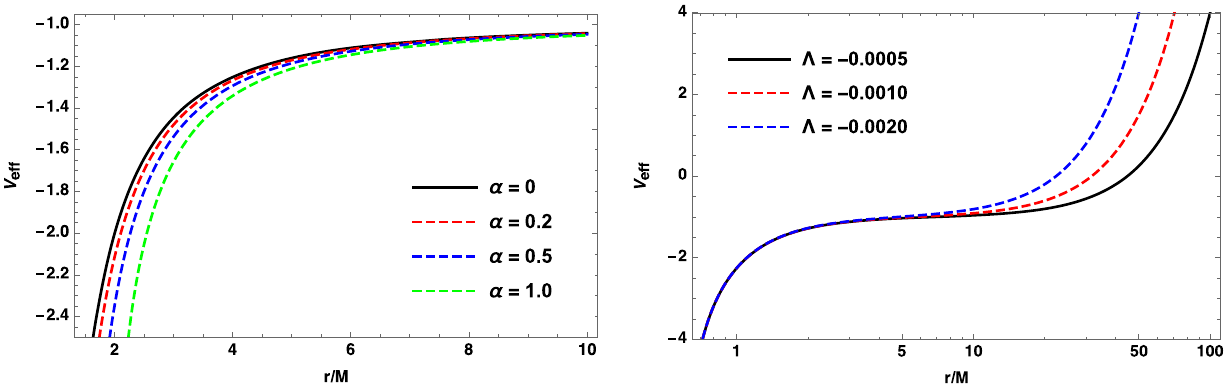
Fig. 1 Radial dependence of the effective potential for massive particles moving around the GB (2+1)-dimensional BTZ black hole. V ef f is plotted for different values of GB parameter α for given (cid:4) = 0 in the left panel, and for different values of (cid:4) for given α = 0 . 1 in the right panel